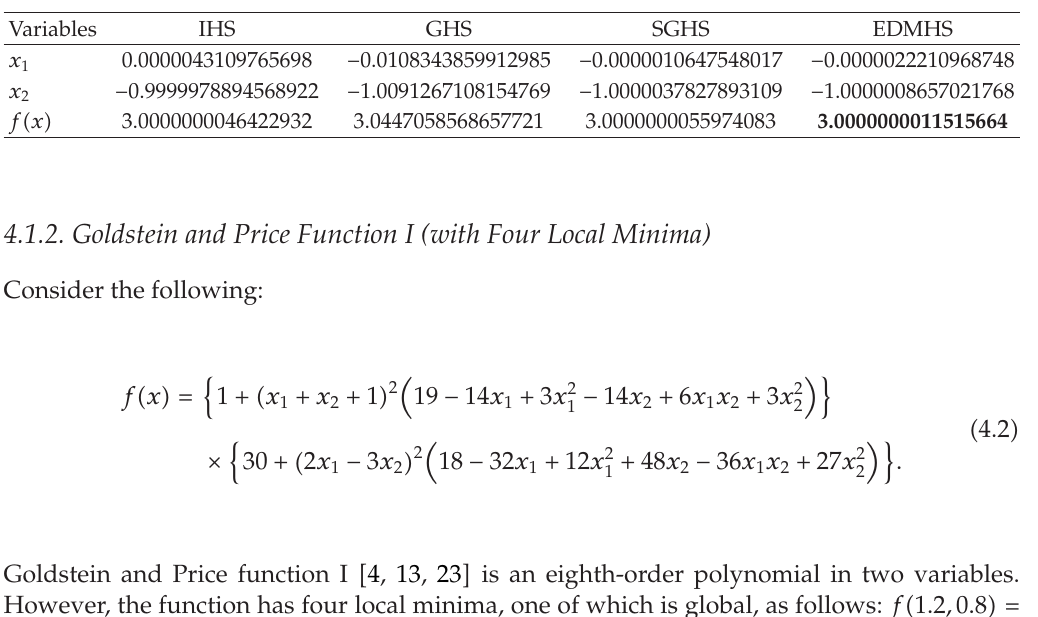
Table 2: Four HS algorithms for Goldstein and Price function